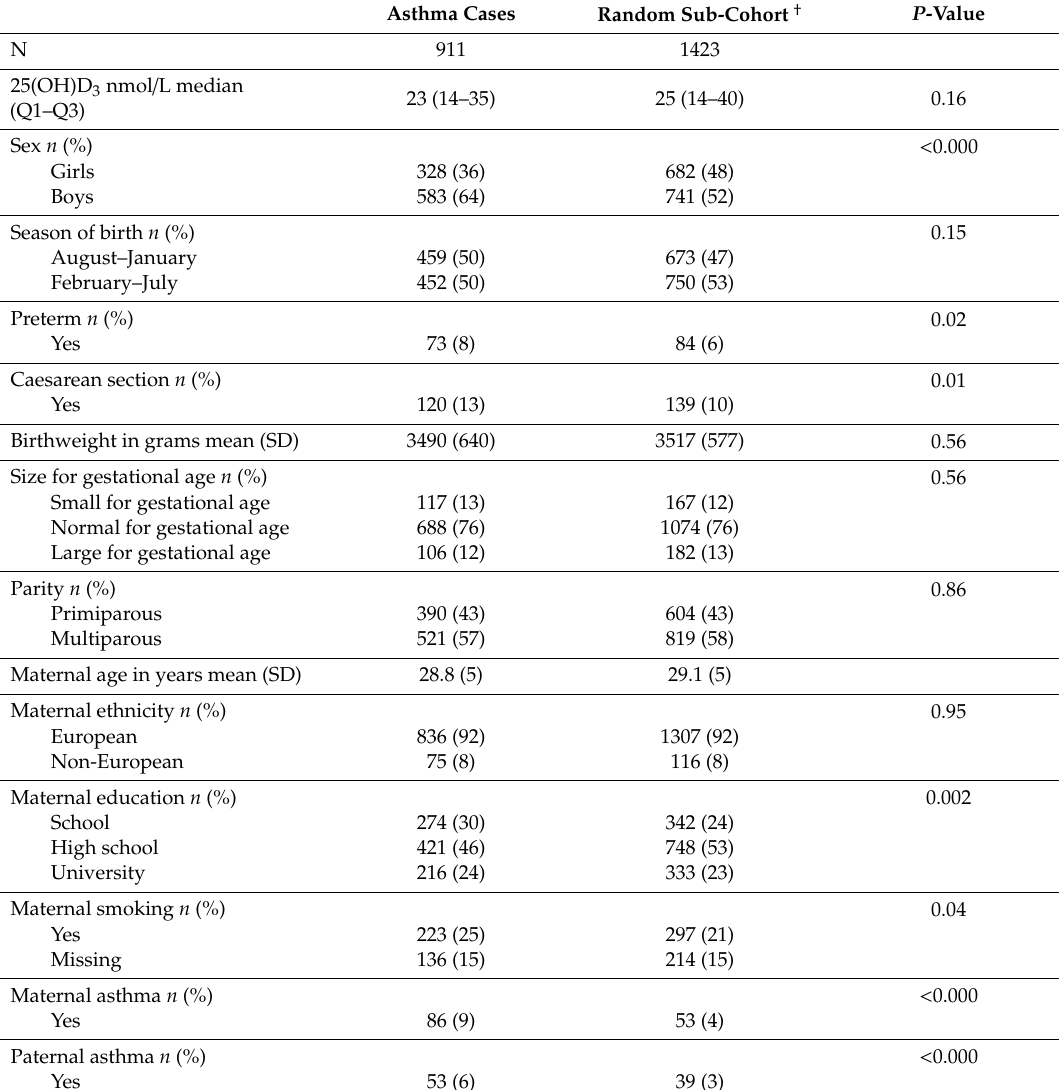
Table 1. Baseline characteristics of the study population.